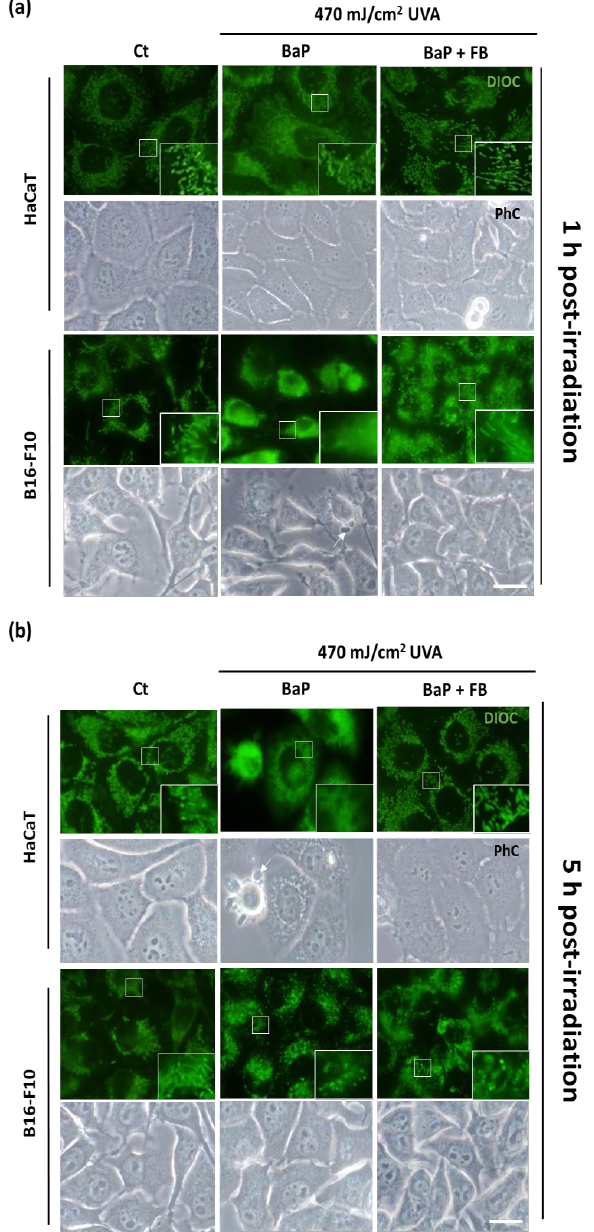
Figure 4. Mitochondrial morphology in HaCaT and B16-F10 cells exposed to BaP, FB and by the combination with UVA light irradiation. Cells were loaded with the DIOC probe BaP and BaP + FB treatments before irradiation. ( a ) Mitochondrial morphology 1 h after irradiation. A spherical appearance showed in cells treated with BaP. Mitochondria of cells treated with BaP and FB maintained the control filamentous morphology. ( b ) Mitochondrial morphology 5 h after irradiation. Mitochondria of cells loaded with BaP appeared with a spherical morphology, while cells treated with BaP and FB retained the normal morphology. Phase contrast images did not show morphological changes in cell shape except for those treated with BaP, appearing some of them with small blebs due to cytotoxic effects of the treatments (arrows). Scale bar: 20 µ